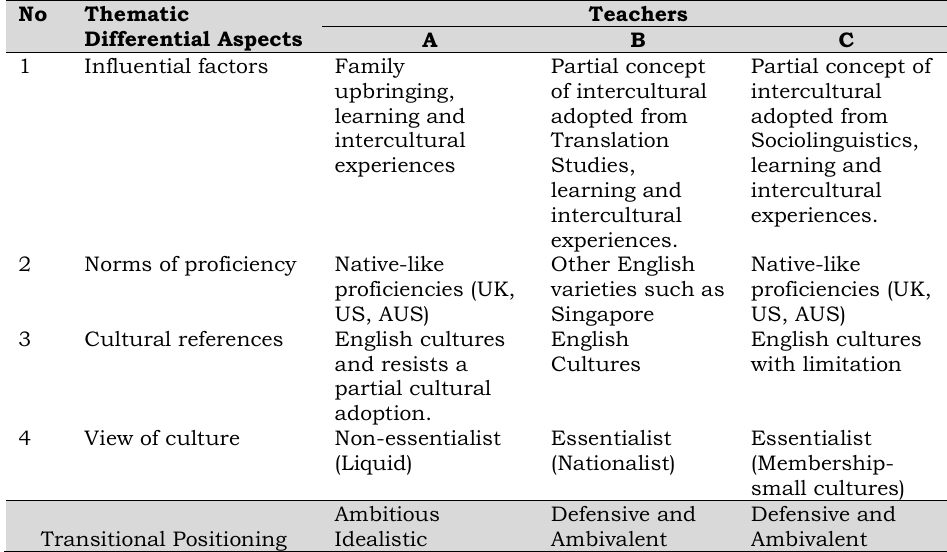
Table 2. Salient differences of university teachers’